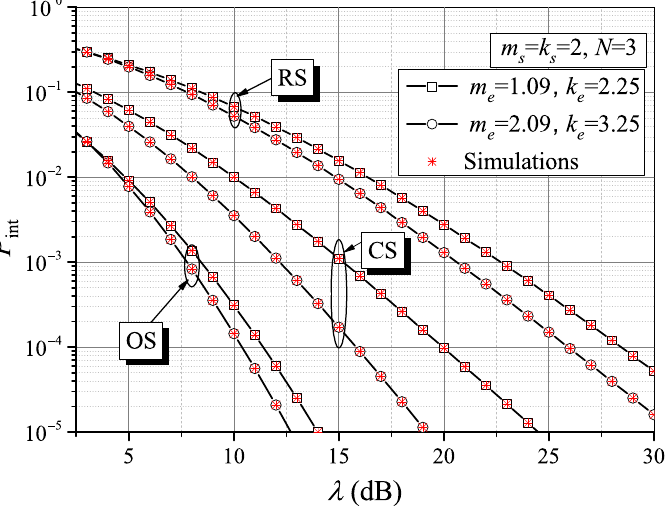
Figure 5. The intercept probability for different fading/shadowing conditions over wiretap channels. In order to avoid complexity and illegibility of the Figure legends, the path loss impact was not included in the previous Figures. Hence, Figure 6 shows the required values of the average MER versus the ratio r to reach the intercept probability of 10 − 3 and 10 − 4 , under CS and OS schemes. Increasing the parameter r indicates larger distances between the scheduled sensor and the sink in comparison to the distances between the sensor and eavesdropper, which results in higher MER values required to obtain the specified intercept probabilities. The results also show that the CS scheduling is more dependent on the ratio r , as well as of the variations of channel conditions in comparison to the OS